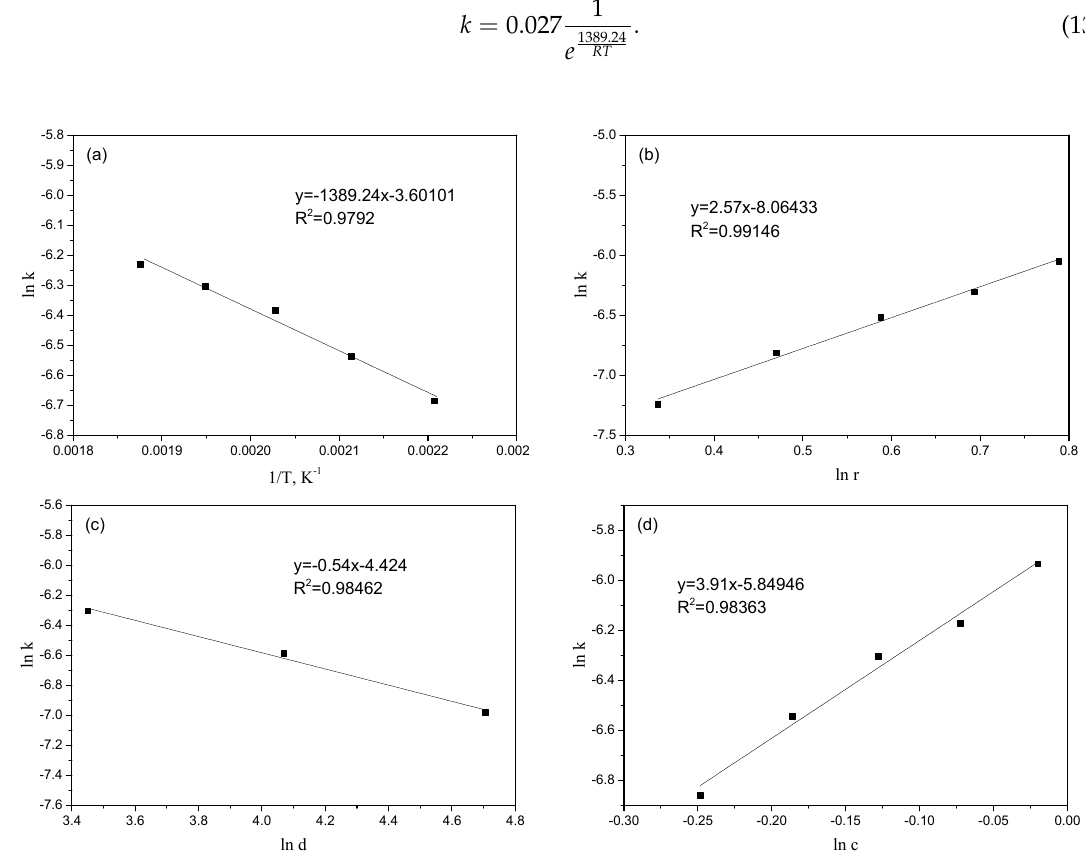
Figure 9. Relationship between ln k and 1 / T , ln r , ln d , ln c : ( a ) the Arrhenius plot of the reaction; ( b ) relationship between ln k and ln r ; ( c ) relationship between ln k and ln d ; ( d ) relationship between ln k and ln c .